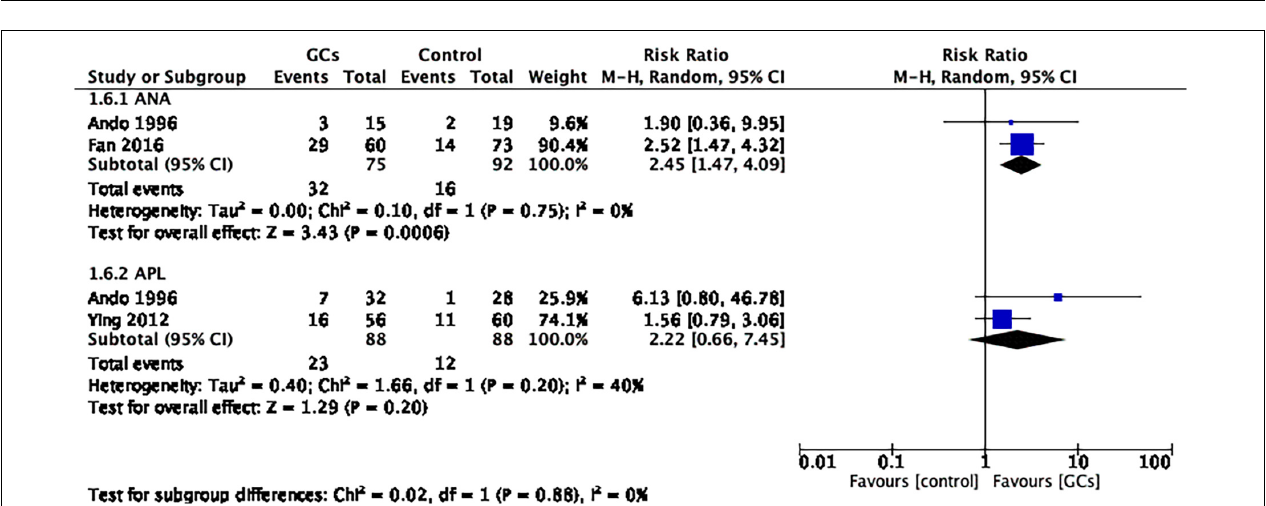
FIGURE 4 | Forrest plot for comparison: glucocorticoids versus no glucocorticoids/placebo, outcome: II. I Live birth rate per couple. A total of seven studies provided the live birth rate by evaluating the effect of glucocorticoid administration. The meta-analysis concluded that it favors peri-implantation glucocorticoids compared to no glucocorticoids (RR 1.92, 95% CI 1.17–3.16, p = 0.009, six cohort studies, 644 women, I 2 = 64%).